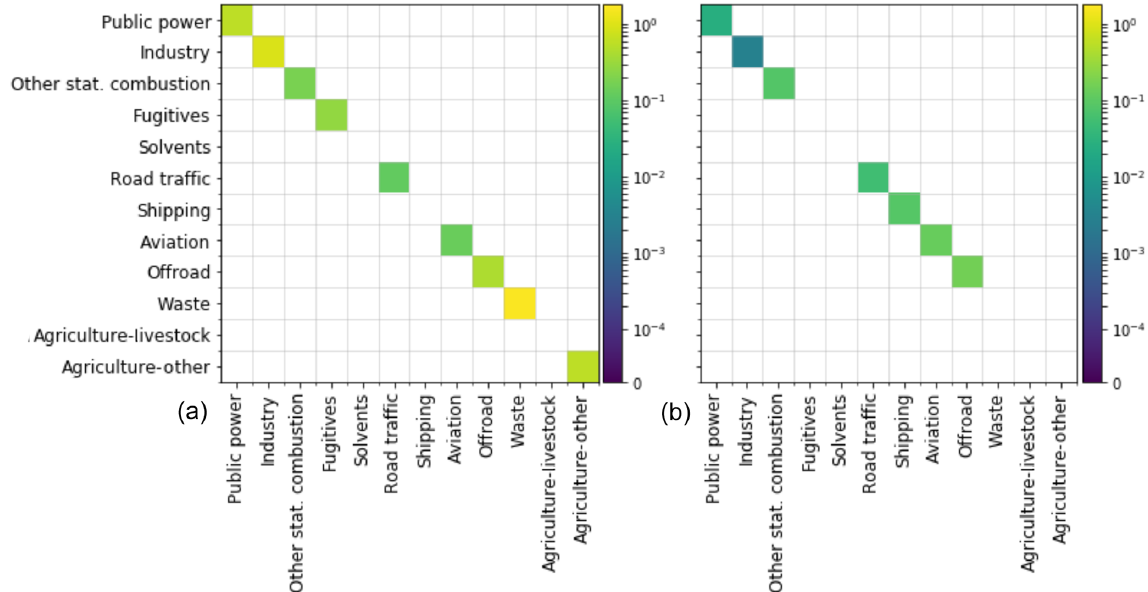
Figure 3. Covariance matrices for spatial proxies (a) and time profiles (b) per aggregated source sector. These are the same for CO 2 and CO. A white space on the diagonal indicates this sector is not included in the Monte Carlo